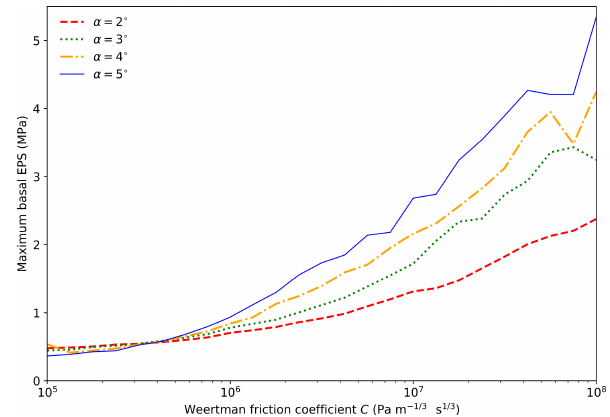
Figure 7. Basal EPS maximum plotted with the notch length equal to l crit + 25m across a range of Weertman coefficients and surface